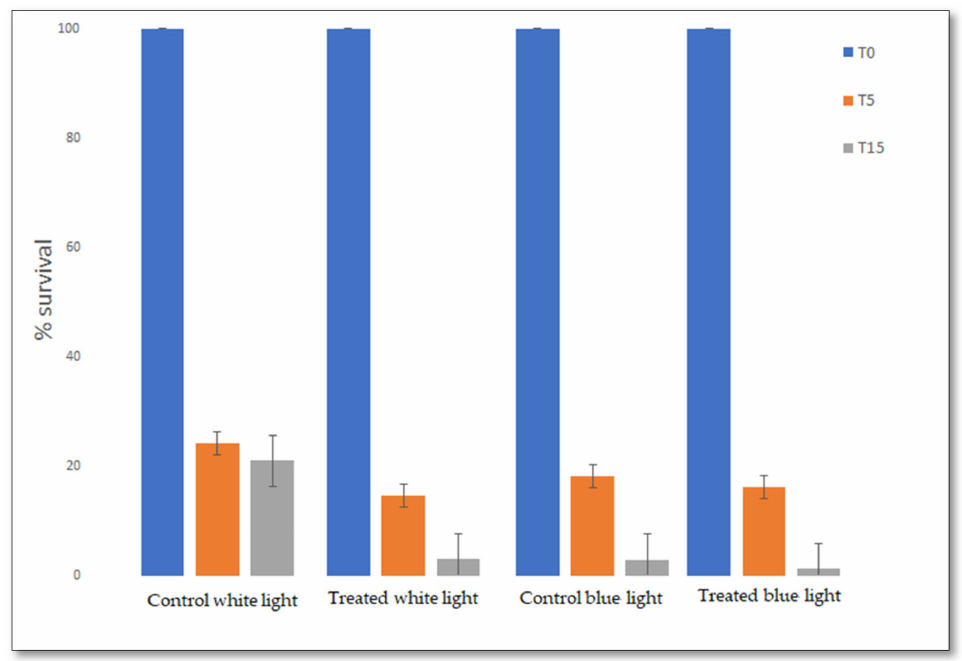
Figure 6. The effect of TiO 2 -coating, independently of mask type. The means of all observations obtained with coated or not coated-TiO 2 masks are shown as percentages of survival ( E. coli CFU/mL) at time 0 (T 0 ), 5 min (T 5 ), and 15 (T 15 ) minutes of exposure of white-visible and blue light. The combi- nation of visible light irradiation and TiO 2 -coated show an enhancement of the antimicrobial activity, suggesting that the coating of TiO 2 can be useful with visible light irradiation and independently of the type of